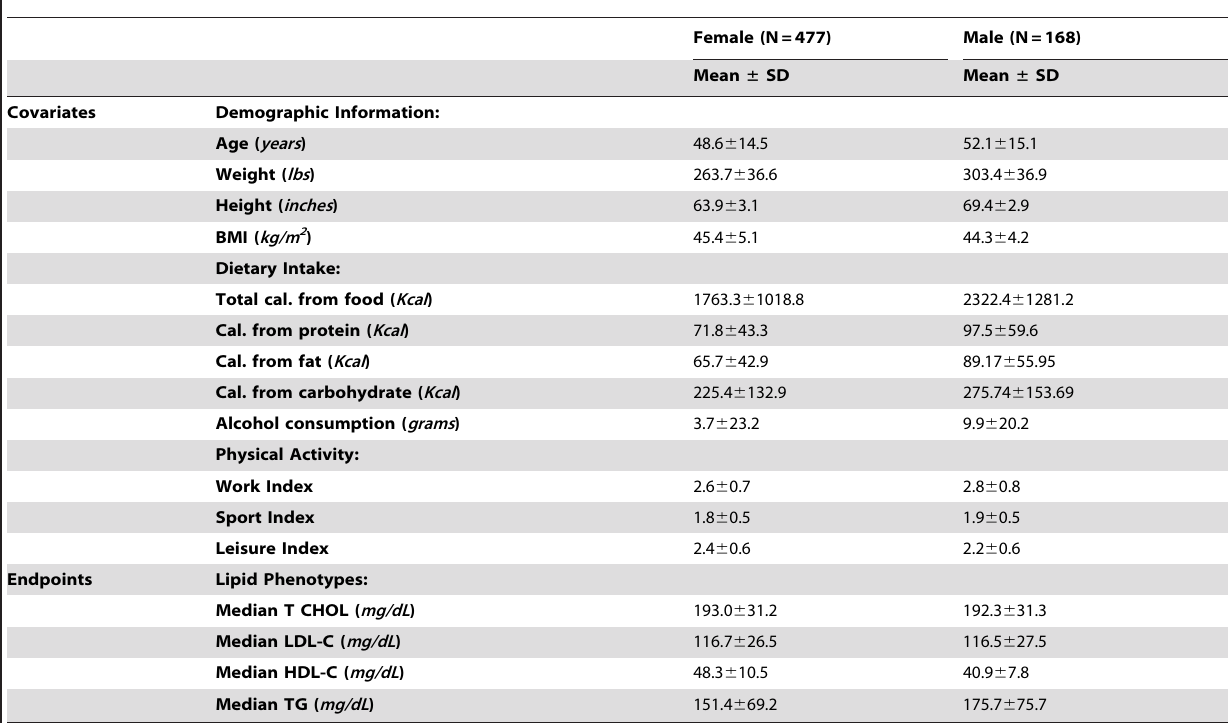
Table 1. Patient